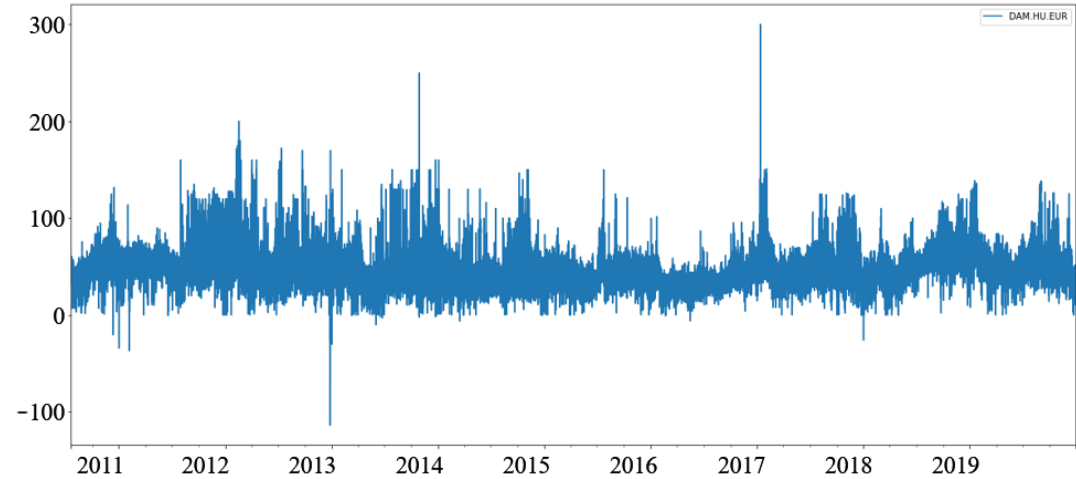
Figure 1. Hourly electricity prices on day ahead HUPX market.